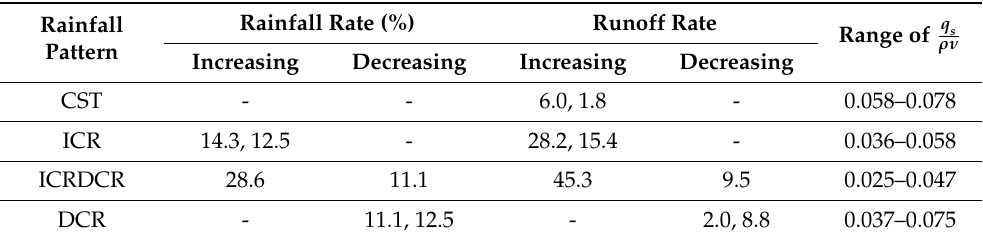
(refer to Figure ρν